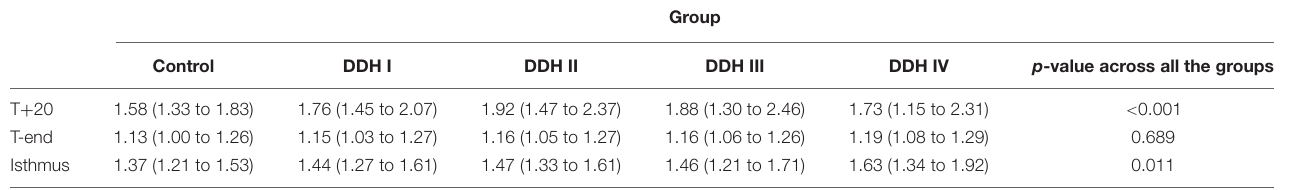
FIGURE 4 | The plot of femoral medullary roundness index (FMRI) for all subject groups. TABLE 5 | The femoral medullary roundness index (FMRI) in all subject